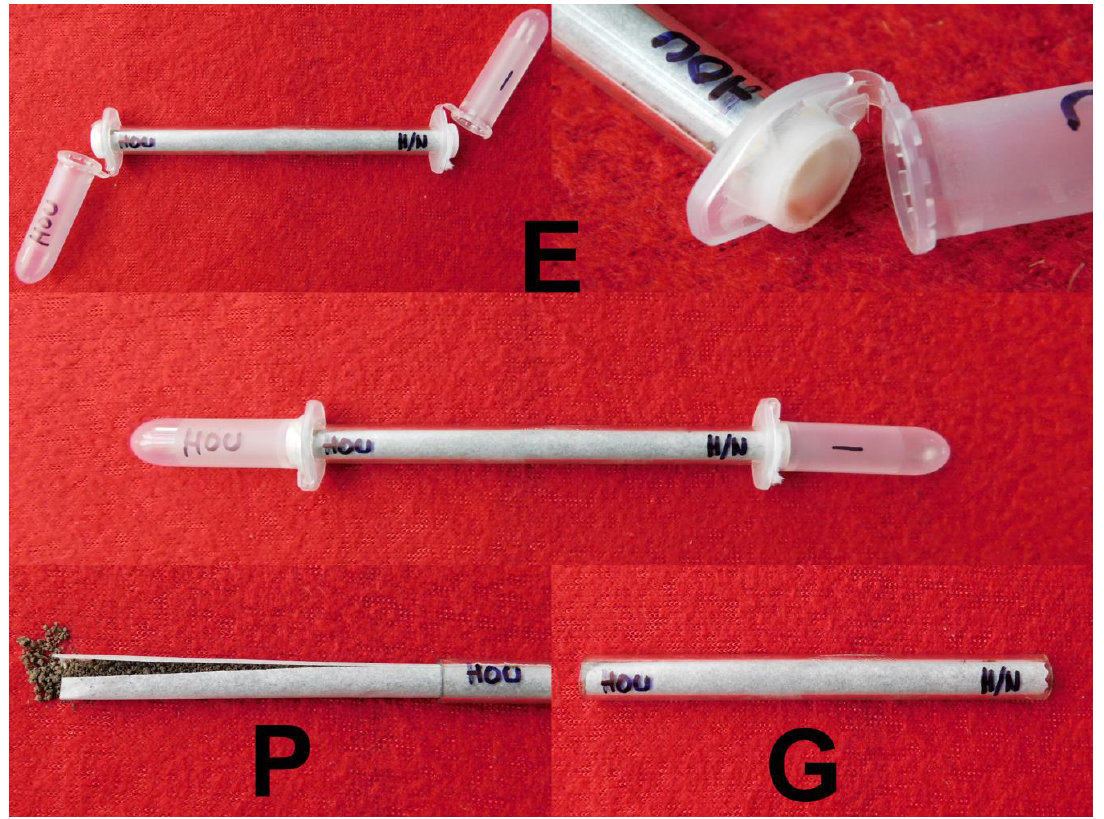
Figure 2. Design of the glass tube experiments. Eppendorf tubes ( E ), glass tube ( G ), parchment paper ( P ).